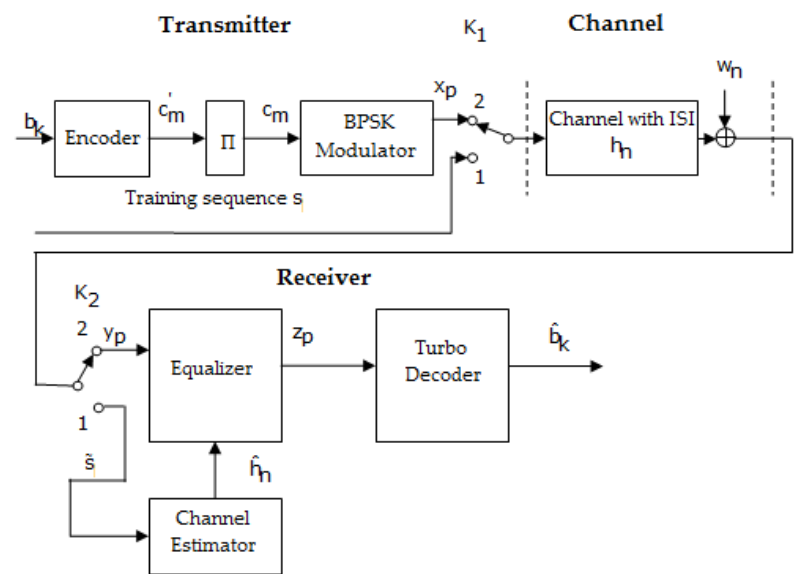
Figure 7. Block diagram of the transmission–reception system that performs the estimation and the equalization of the channel at the reception, in the case of applying turbo codes [46]. Related to Figure 7, Π represents the inter-leaver block; ' c represents the parity m